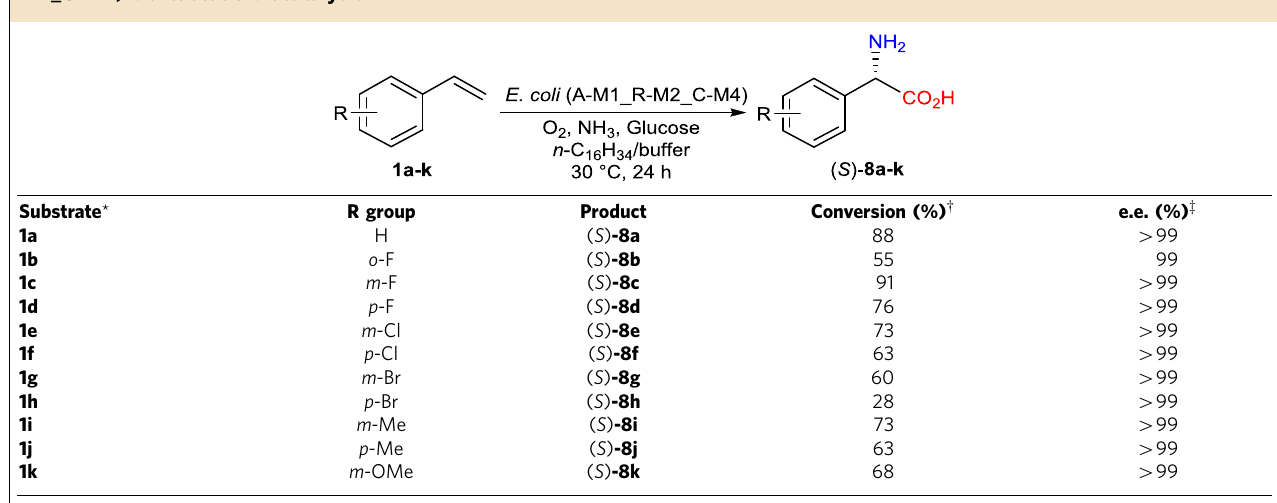
Table 4 | Regio- and enantioselective functionalization of terminal alkenes 1a–k to a -amino acids 8a–k with E. coli (A-M1_R- M2_C-M4) via cascade